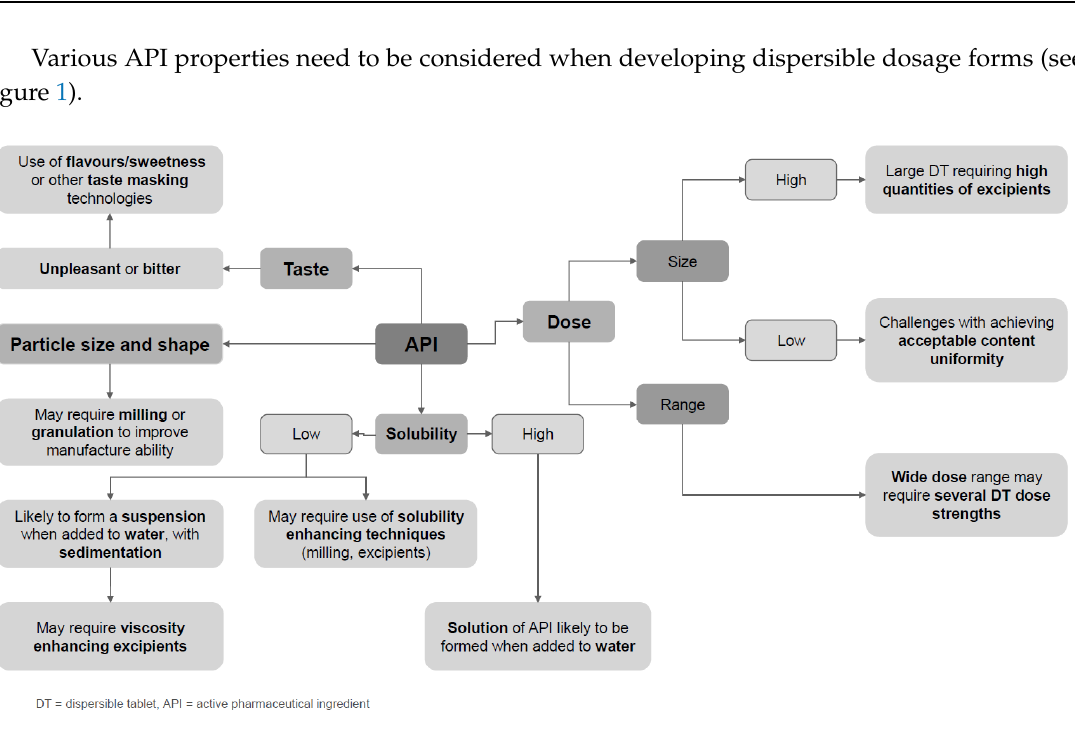
Figure 1. Map of factors of active pharmaceutical ingredients (API) affecting dispersible tablet formulation approaches.